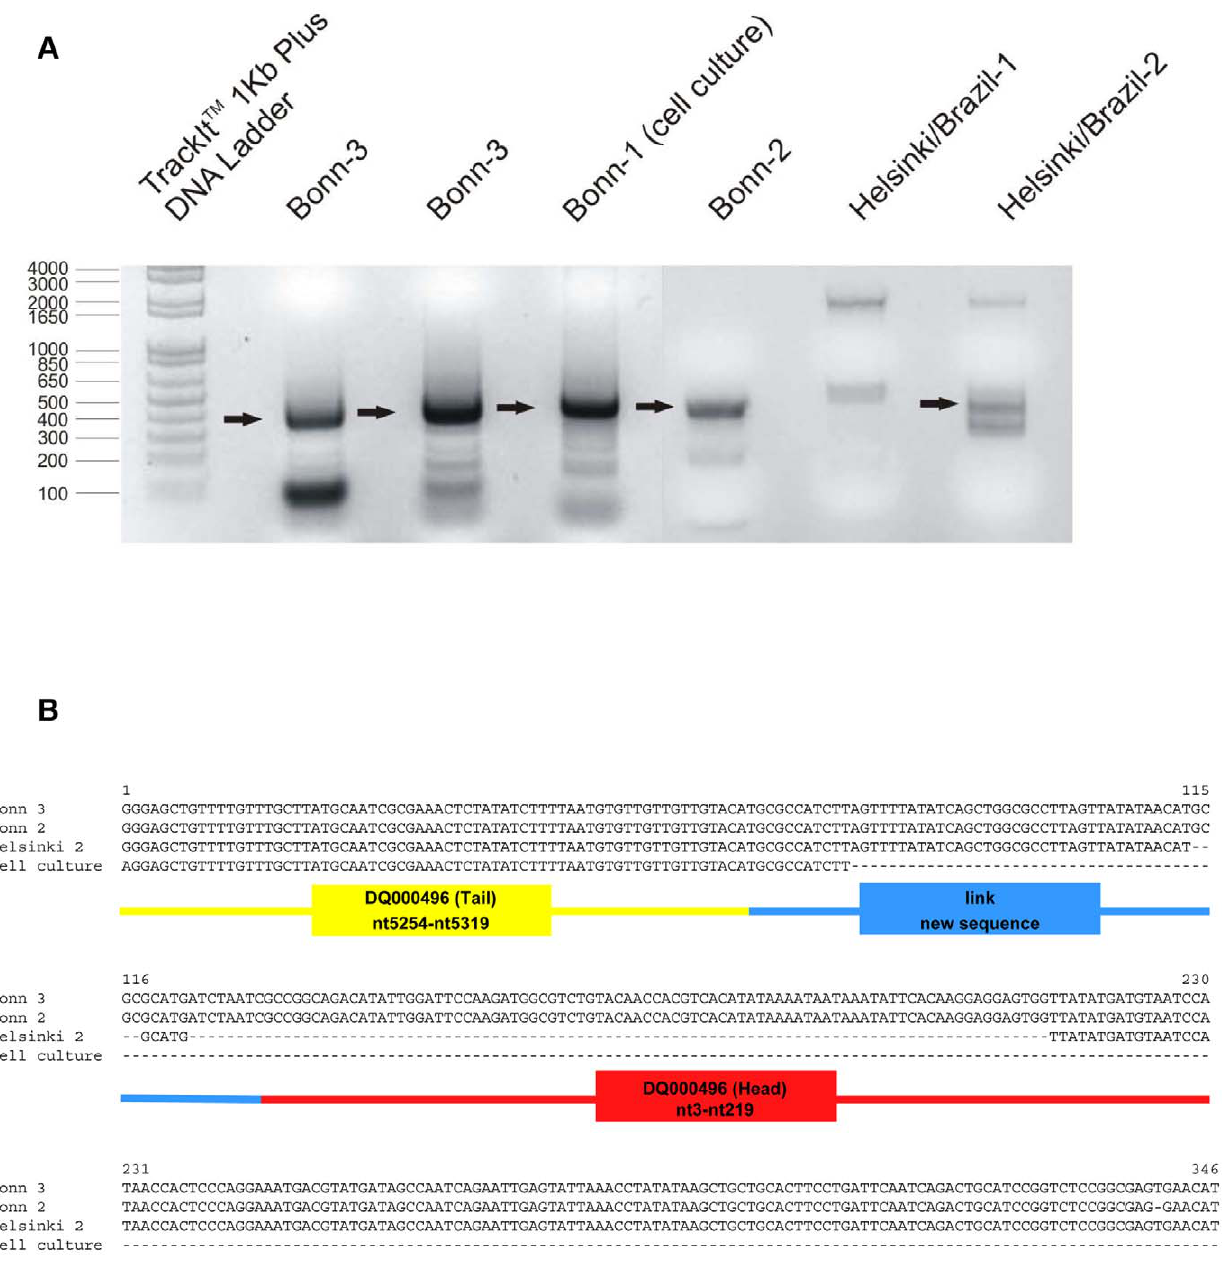
Figure 5. Human bocavirus forma head-to-tail sequences. a. Agarosegelelectrophoresesofhead-to-tailPCRfromdifferentclinicalHBoV- isolates. Arrows indicate that the corresponding band was gel-extracted and sequenced. Sequences are aligned in figure 3b. b. AlignmentofHead- to-TailPCRproductfromdifferentisolatesandcellcultureofHBoV. All PCR products contained a sequence from the tail of several published clinical isolates that except single point mutations perfectly matches with the prototype sequence of the ‘‘Allander strain’’ DQ000496 (Tail), nt5254– nt5319. This region is followed by a so far unknown sequences, here referred to as linking sequence, which in turn is followed by head sequences conserved in several strains, again perfectly matching to the ‘‘Allander strain’’ DQ000496 (Head), nt3–nt219. The sequence of the PCR amplificates is highly compatible with a classical rolling circle replication (fig. 3c).